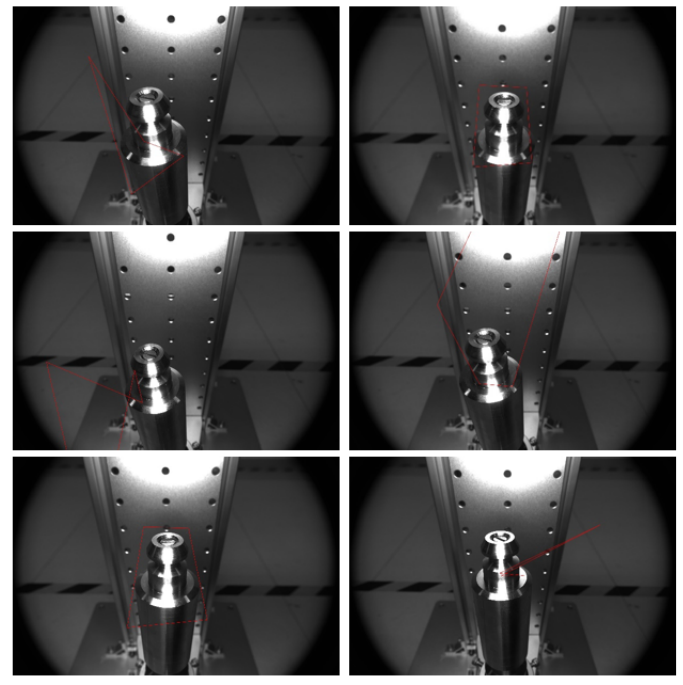
Figure 4. Feature-matching